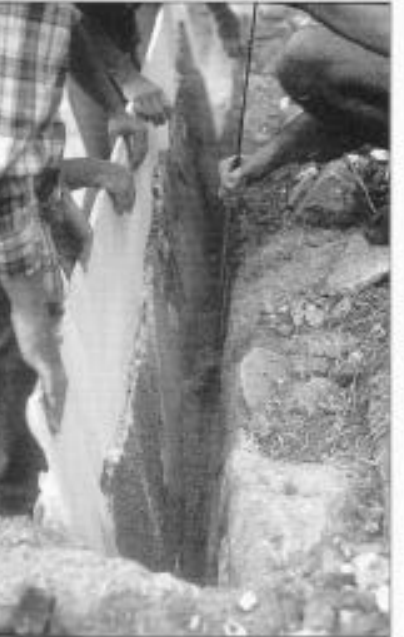
Figure 1 Detaching painted plaster that